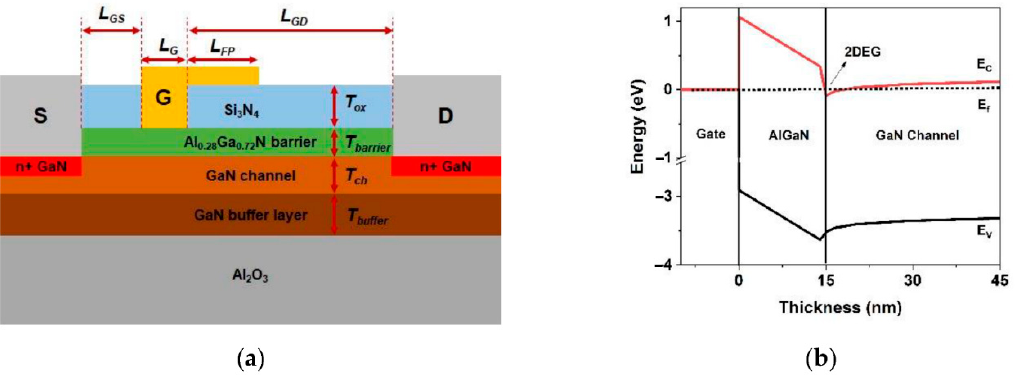
Figure 12. ( a ) View of AlGaN/GaN HEMT with FP structure and ( b ) equivalent energy band profile. The architecture allows for breakdown voltage improvement while preventing current collapse. Reprinted with permission from ref. [19]. Copyright 2021 MDPI.